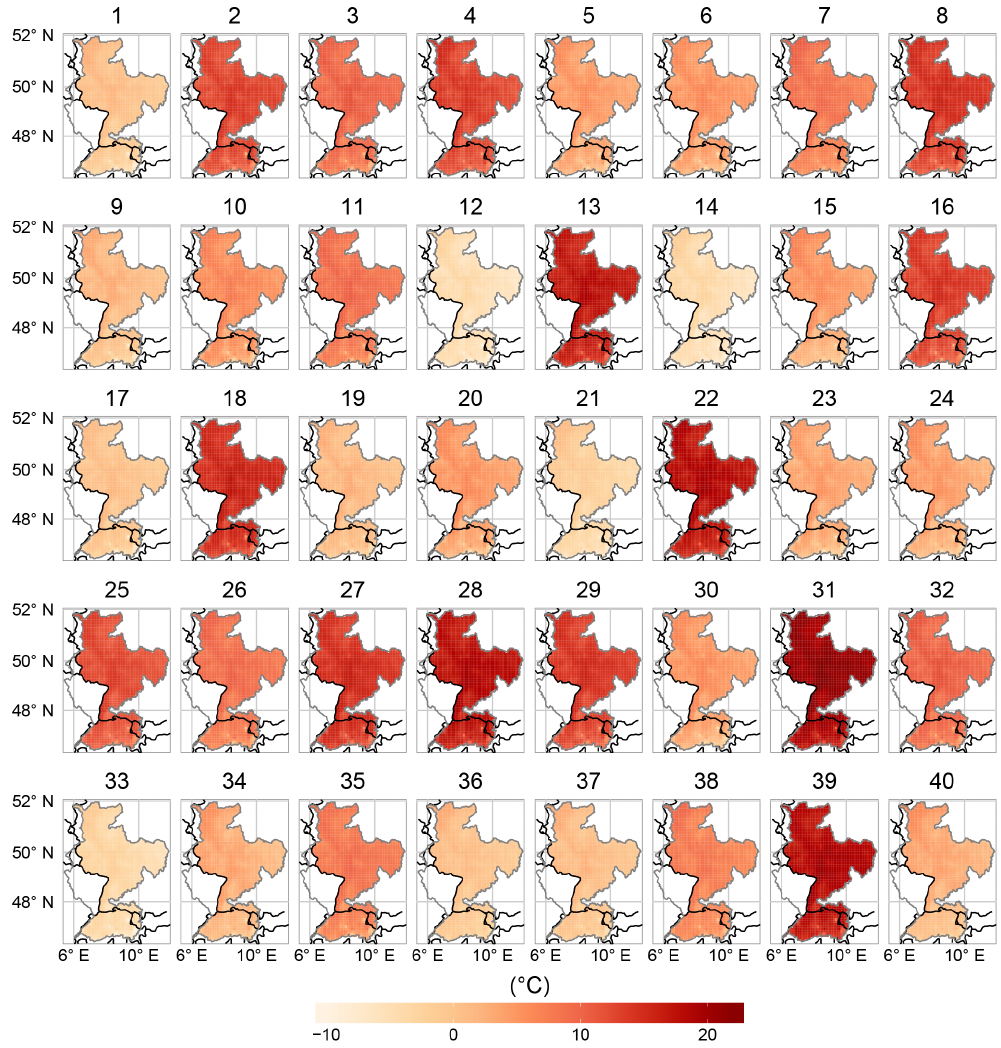
Figure A1. Average (over all days with the respective pattern) mean temperature for all weather patterns. Black lines denote state bor- ders, the grey line the Rhine